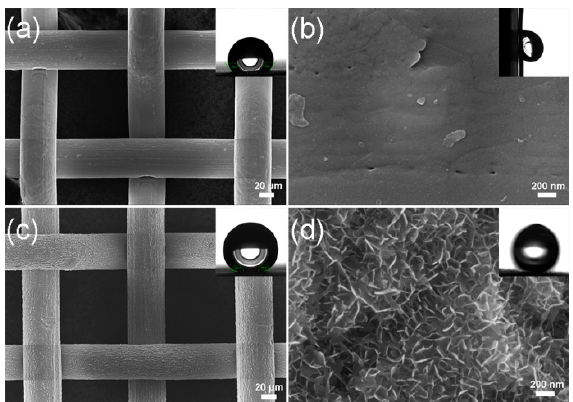
Figure 4. SEM images of the surfaces of bare ( a , b ) and superhydrophobic Cu 2 O mesh ( c , d ). The insets show the optical images of the water contact angle and sliding angle.